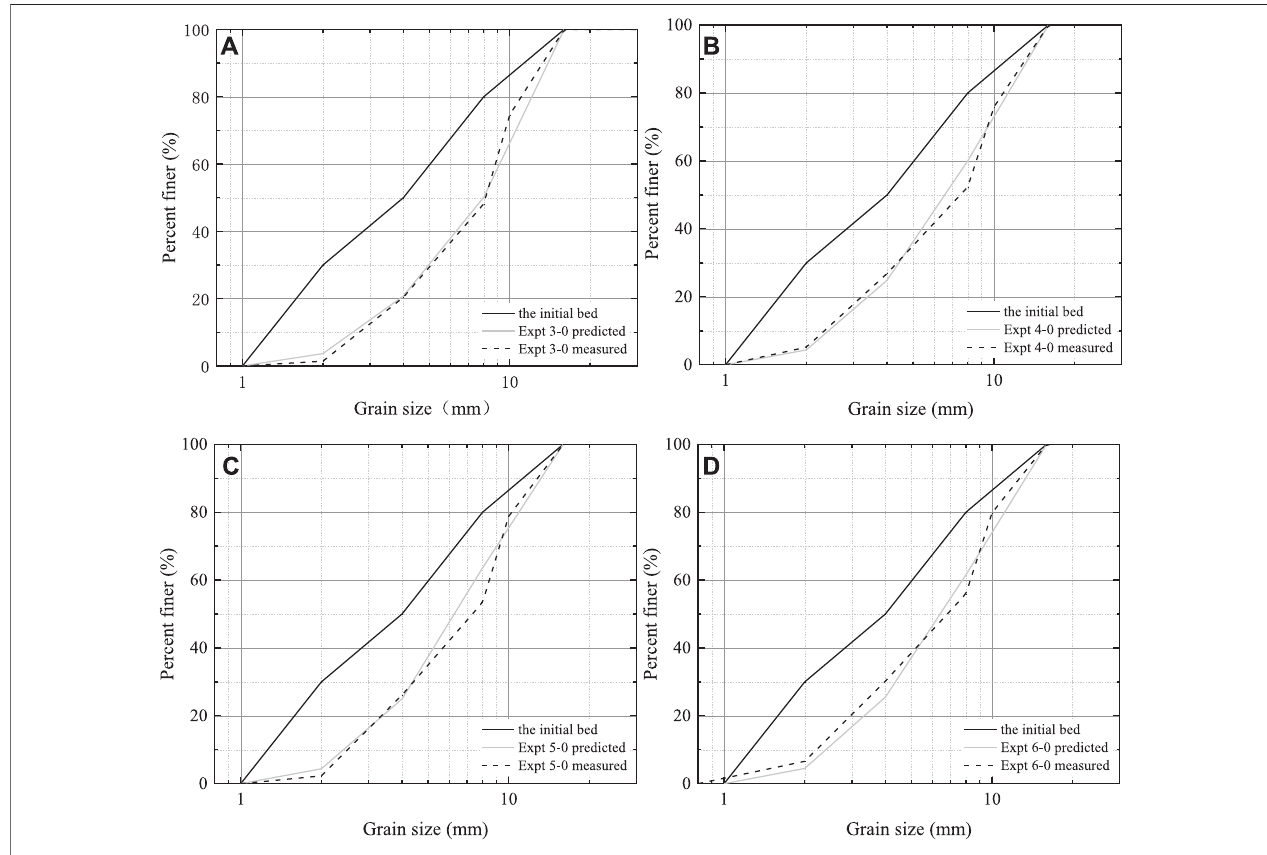
FIGURE 2 | Comparison between the predicted and measured results of the bed surface size distribution after the initial static armor layer is formed in the Experiments 3-0-6-0 (A) Expt. 3-0, (B) Expt. 4-0, (C) Expt. 5-0, (D) Expt. 6-0.